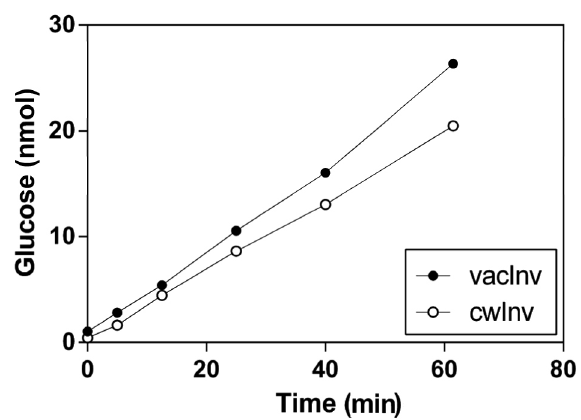
Figure 3. Time course of invertase reaction. Extraction was perfor- med on apical leaves pooled from a single plant. Assays of vacINV and cwINV were allowed to proceed for 1 hour. Samples were re- moved at the indicated time points, and glucose accumulation im- mediately measured.